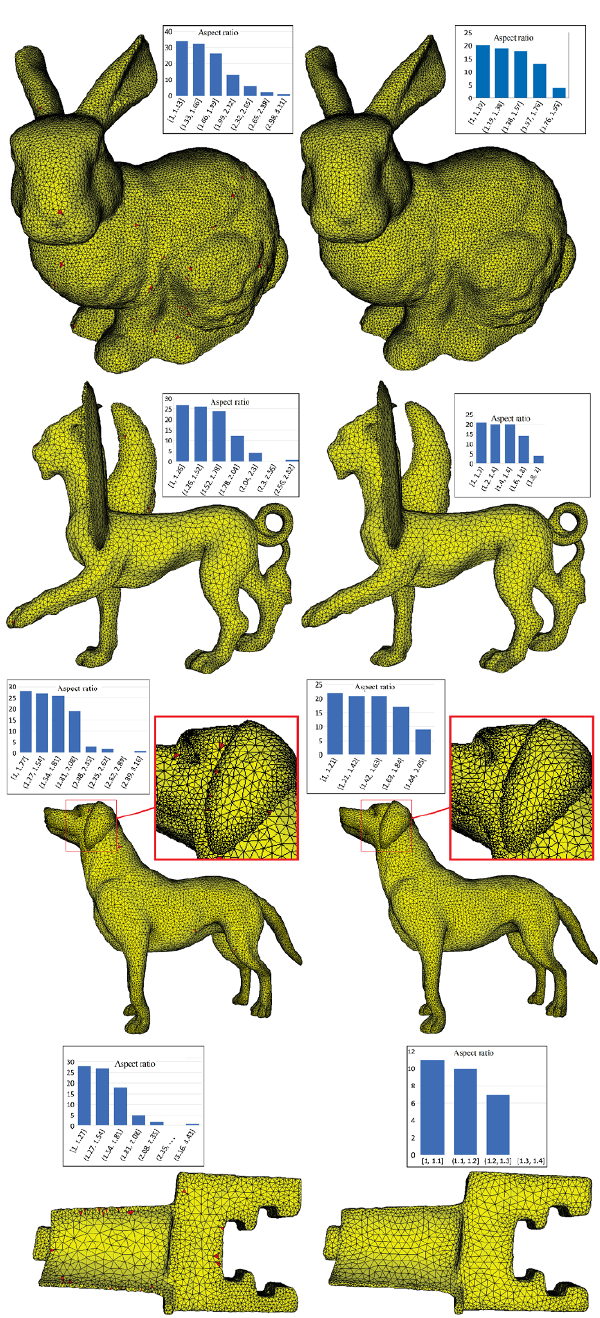
Fig. 8 Remeshing results, adaptive mesh. Triangles with small angle ( < 30 ◦ ) are shown in red. Left: RAR results. Right: Our